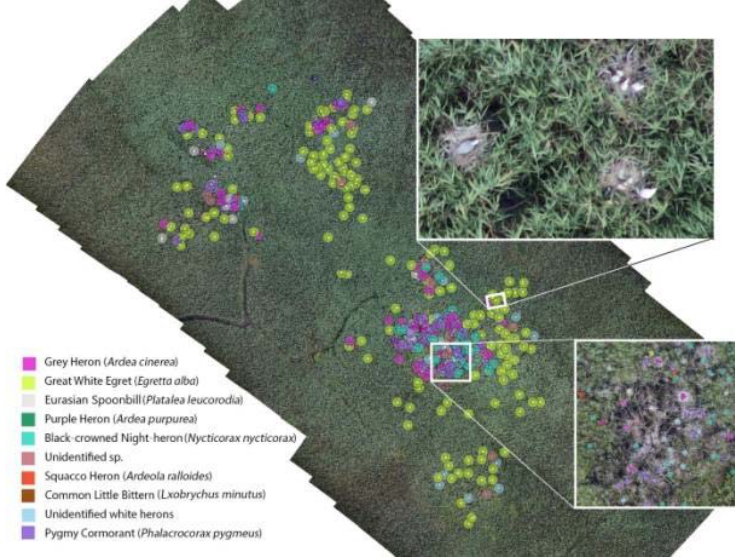
Figure 8. The resulted colony map. An orthophoto mosaic with 0.7 cm spatial resolution with an indication of the detected individuals (points) and nests (full circles).